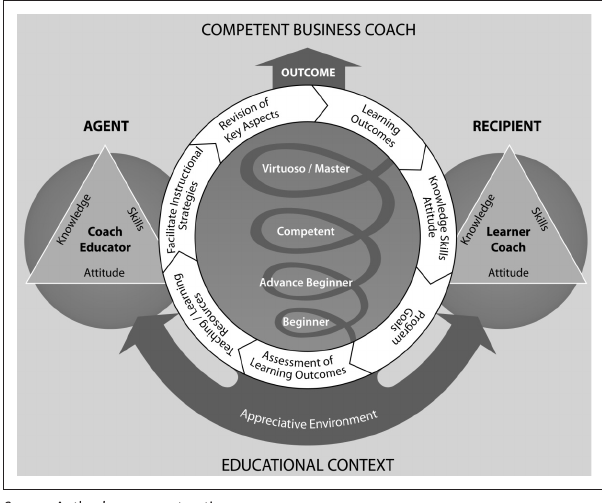
FIGURE 1: Conceptual framework for business coaching